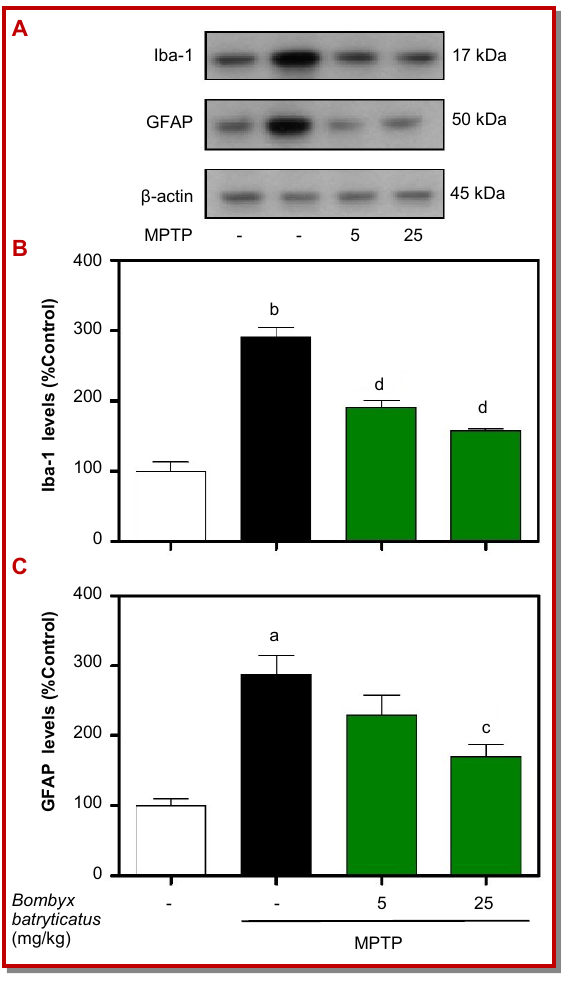
Figure 2: Effect of B. batryticatus on MPTP-induced microglial and glial activation in SNpc of mice brain. (A) Western blot analysis of Iba-1 and GFAP (microglial and glial activation makers, respectively). β -actin is the internal control. Determi- nation of (B) Iba-1 and (C) GFAP levels in the SNpc. Values are presented as mean ± standard error of the mean. a p<0.01 and b p<0.001 vs. control group; c p<0.05 and d p<0.001 vs. MPTP-